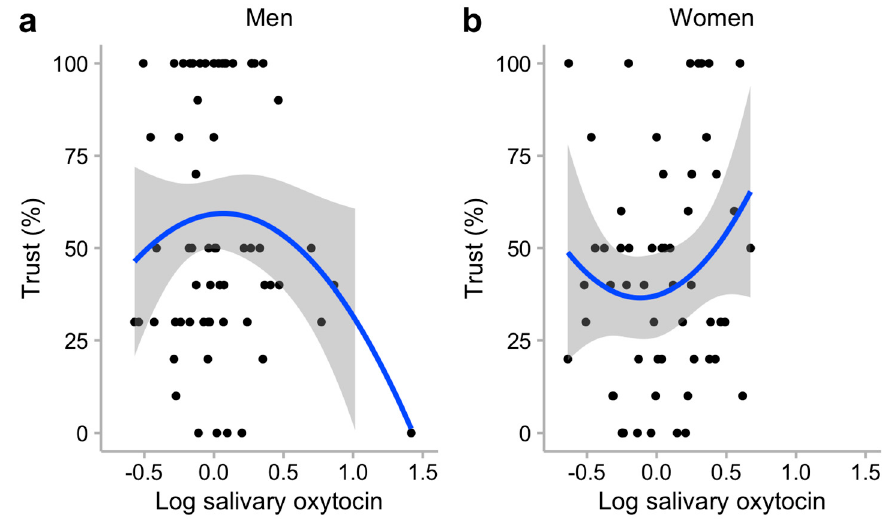
Figure 2. The relationship between salivary oxytocin (log-transformed) and trust in ( a ) men and ( b ) women. Table 2. Results of linear and nonlinear regressions of oxytocin concentrations on reciprocity. Explanatory Variables b Model 1 ( R 2 = − 0.008, p =